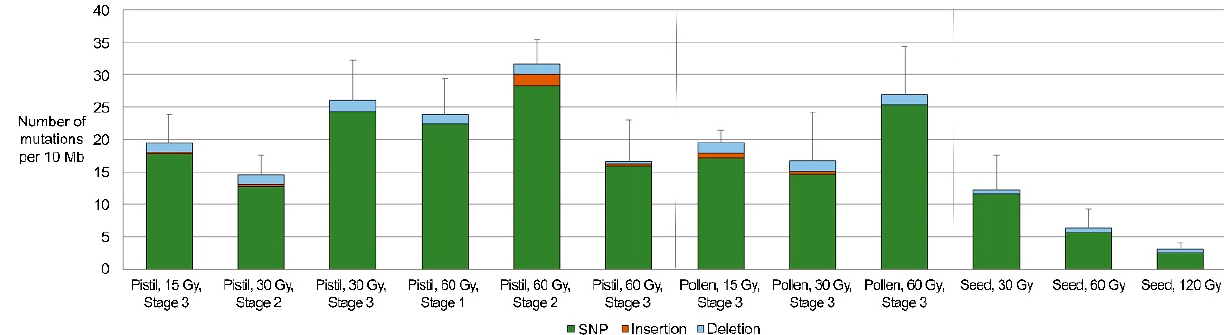
Figure 2. Mutation frequencies in groups of progenies derived from gametophytes irradiated under different conditions. Error bars indicate experimental errors in number of mutations per 10 Mb ( n = 3).